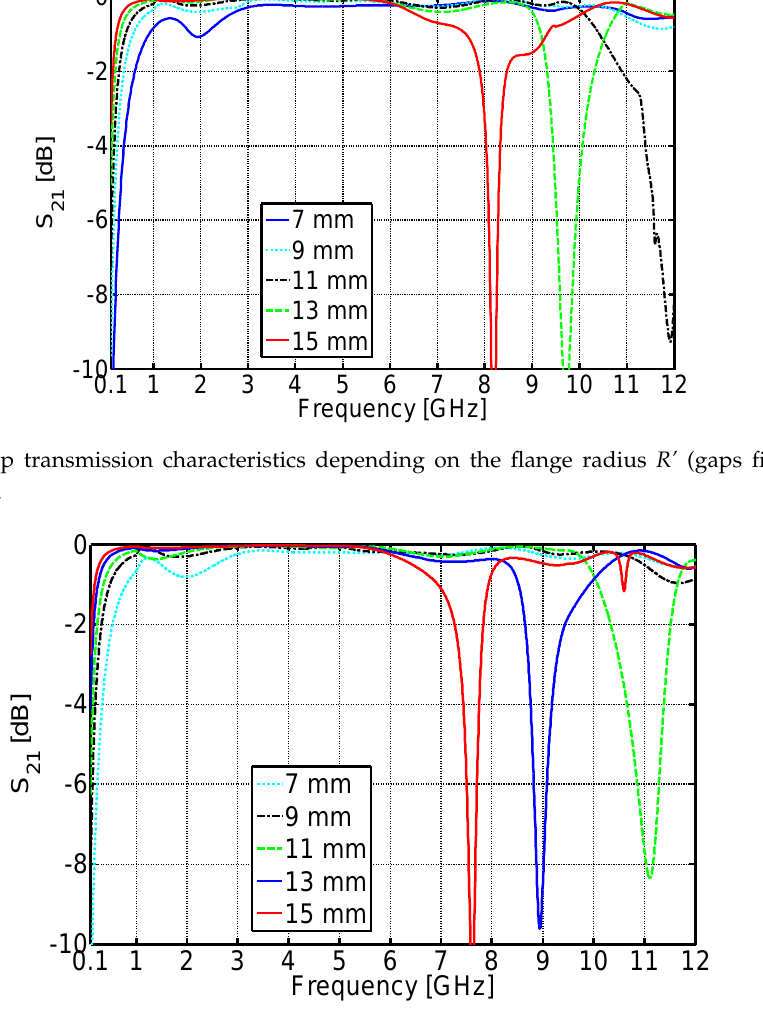
Figure 5. Gap transmission characteristics depending on the flange radius R’ (gaps filled with acetal homopolymer).